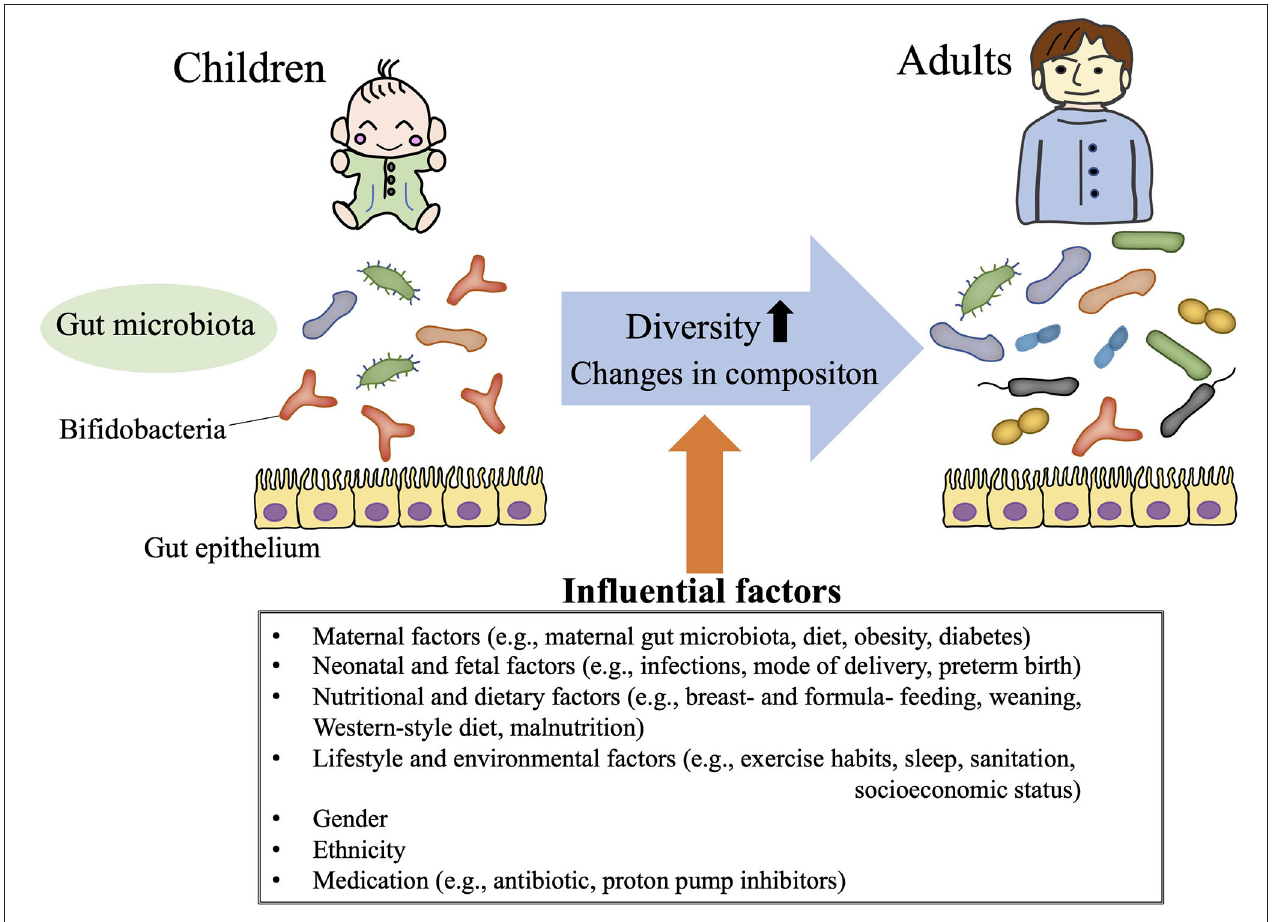
FIGURE 2 | Gut microbiota in children. The gut microbiota demonstrates age-dependent increases in diversity and changes in composition (i.e., relative high abundance of Bifidobacteria throughout childhood). These gut microbiota profiles in children are influenced by various life events (e.g., mode of delivery, weaning,